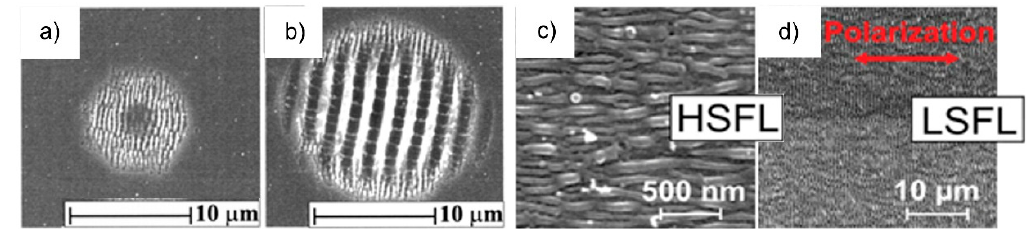
Figure 1. SEM micrographs of laser-induced periodic surface structures: ( a ) HSFL and ( b ) LSFL on InP and ( c ) HSFL and ( d ) LSFL on titanium. ( a , b ) Reprinted from Borowiec and Haugen [19] and ( c , d ) from Bonse et al . [2], with the permission of AIP Publishing.